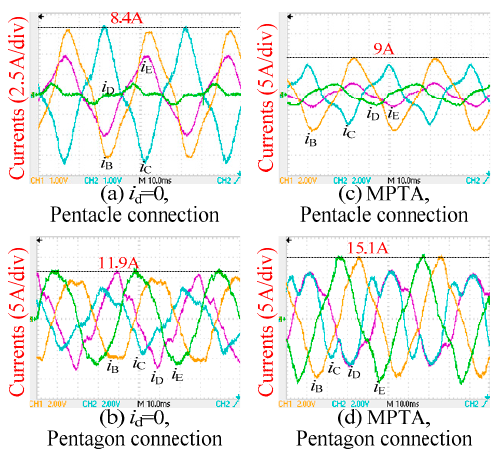
Figure 13. Actual winding phase currents under a single open-phase fault.